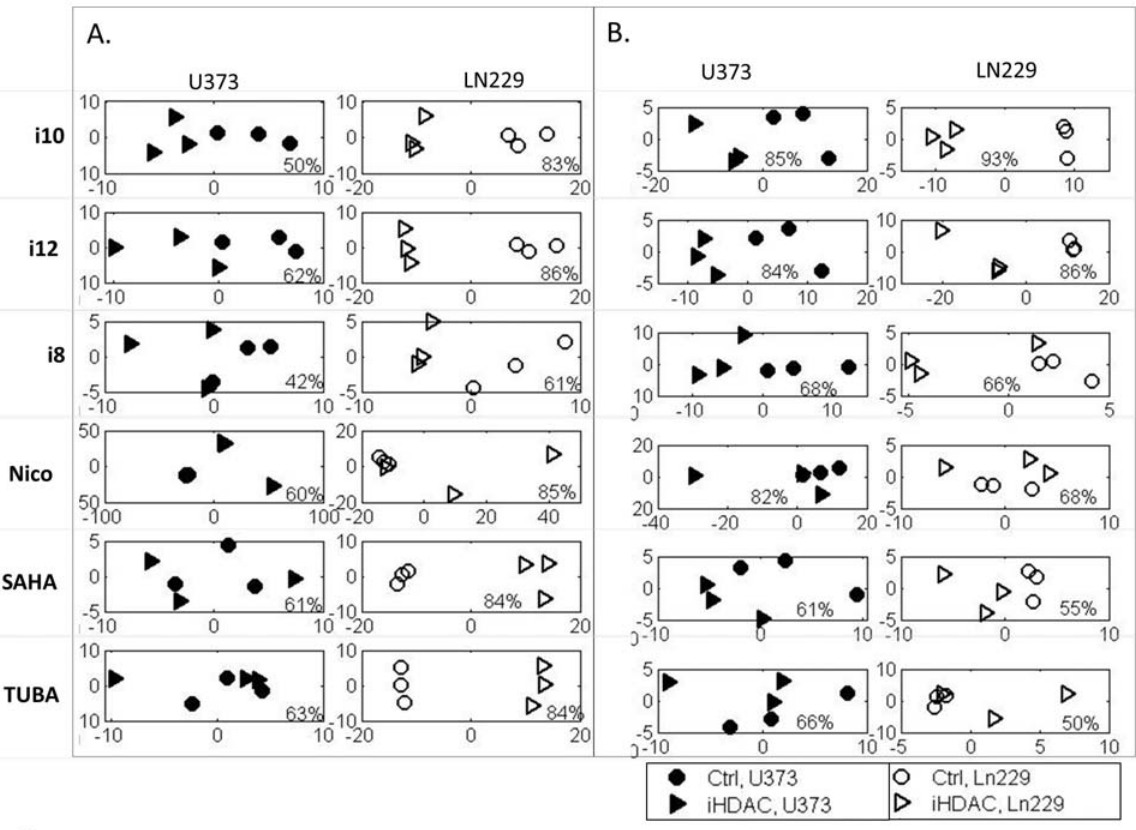
Figure 4. PCA of 1 H 1D NMR spectral data for two cell lines treated with the studied compounds and controls (DMSO). Each treatment has been done in triplicate. PCA has been performed and shown separately for two cell lines and for each compound treatment with the control. ( A ) The analysis of the measurements of intracellular metabolites is shown, and ( B ) the corresponding extracellular samples’ analysis is presented. Each PCA plot includes information about the percentage of variance described by Principal Component 1